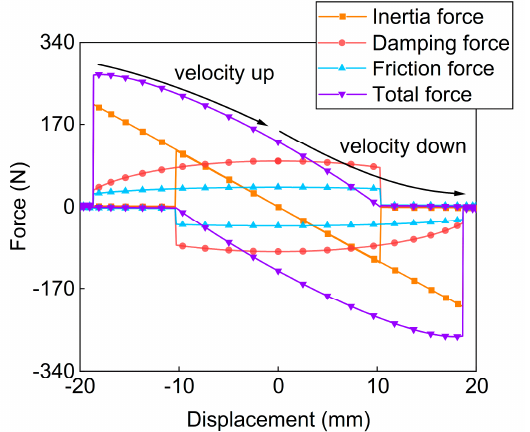
Figure 4. The force − displacement loops of different forces with sinusoidal displacement input. Parameters of input: A = 20 mm, f = 1.0 Hz, R load = 20 Ω .